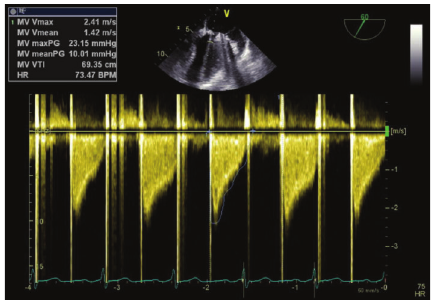
Figure 2: Transesophageal echocardiography of a mitral valve prosthesis. CW-Doppler recording of the transmitral flow shows an increased transvalvular gradient.